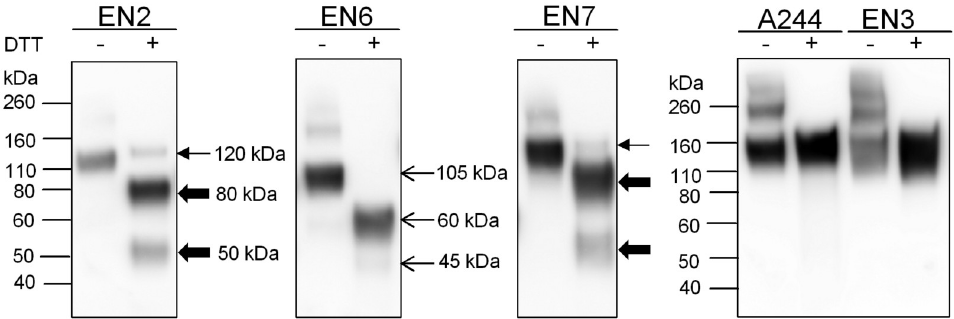
Fig 1. Proteolysis of six HIV Env gp120s expressed in CHO cells as visualized by immunoblot. Clade B HIV Env gp120s from four individuals with neutralization breadth (EN2, EN6, EN7, EN3) were transiently transfected into normal CHOK1 cells. Cell culture supernatant was analyzed by immunoblot, and samples were run non-reduced and reduced with DTT. Full-length gp120 is indicated with thin arrows and the proteolyzed 80kDa and 50 kDa fragments are indicated with thick arrows for EN2 and EN7. For EN6, full-length gp120 runs as 105 kDa due to the presence of only 17 PNGS and has smaller proteolyzed fragments than EN2 and EN7. Blots were probed with a goat polyclonal serum to gp120. The clade CRF01-AE, A244-rgp120 that lacks the clade B GPGRAF consensus sequence was expressed in normal CHOK1 cells and used as a negative control.